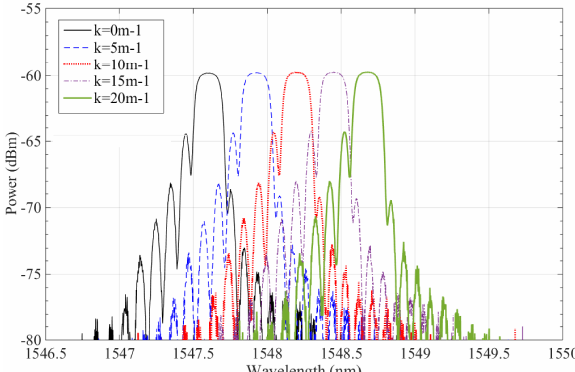
Figure 12. Wavelength shift and intensity of FBG sensor for a morphing wing.